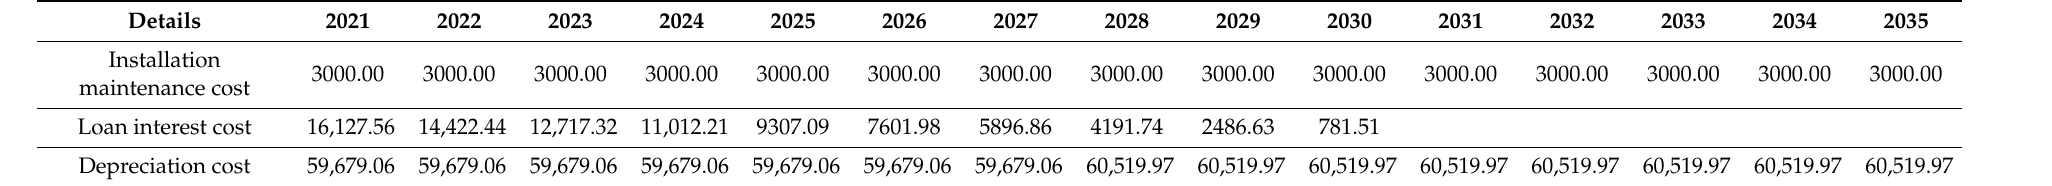
Table 17. Projected costs resulting from the implementation of the project. Source: designed by authors.